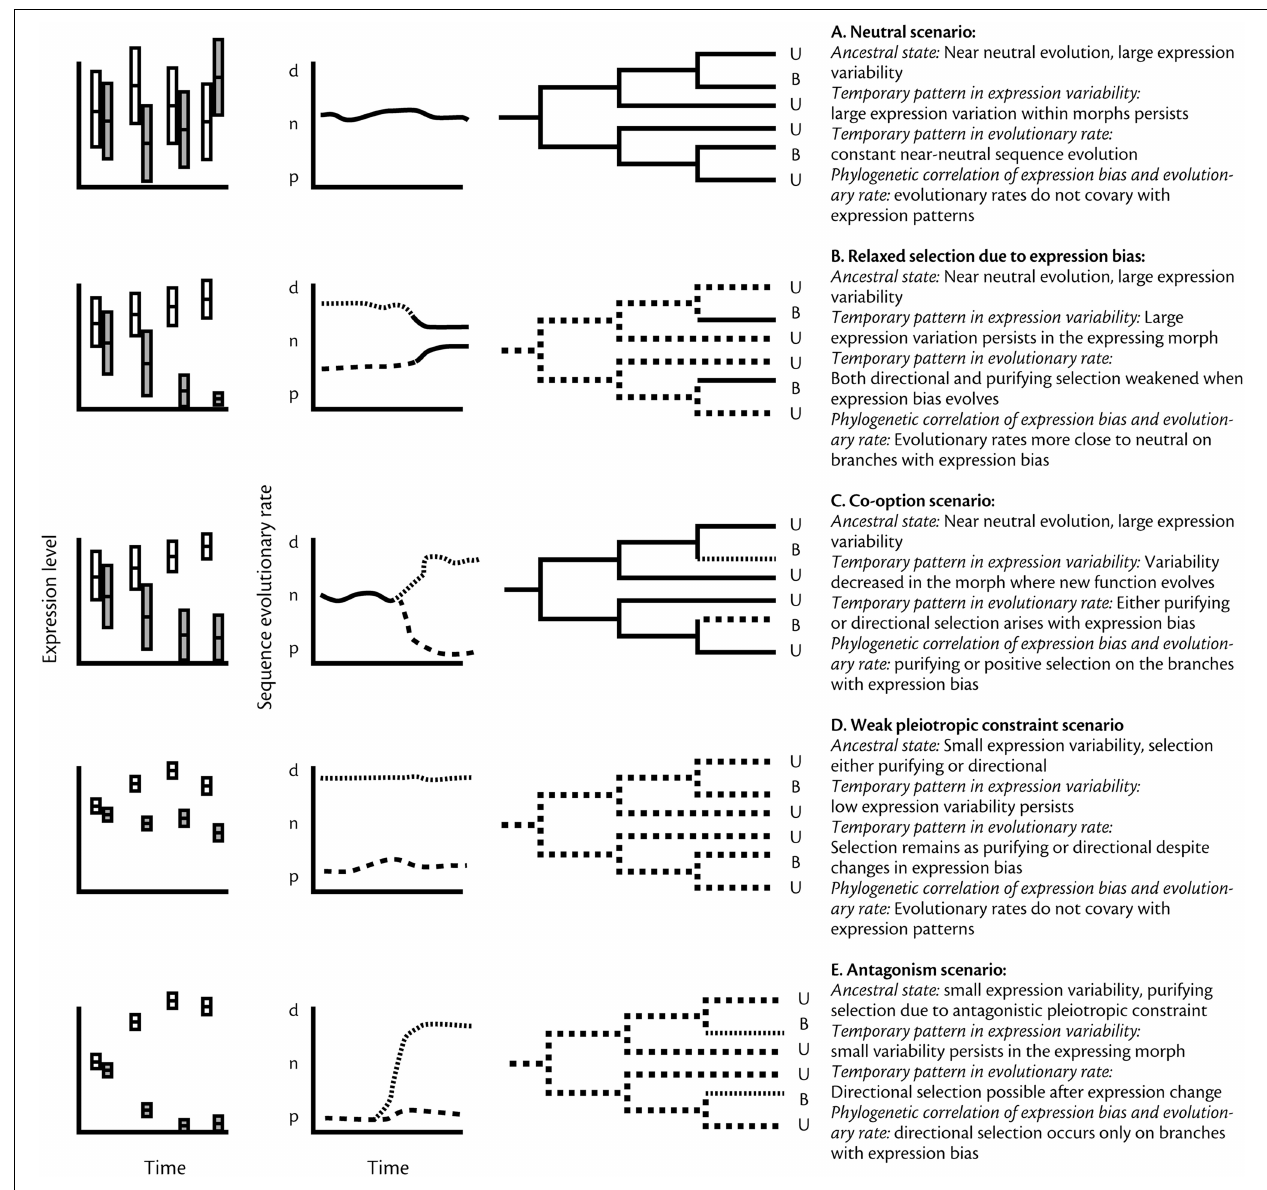
FIGURE 1 | Predicted patterns of evolutionary history of gene expression and sequence evolution for the five scenarios outlined in the text. The left hand column shows the expected relative variation in expression within morphs and hypothetical changes in morph biased gene expression over time. White bars for morph 1 and gray bars for morph 2. The second column shows how average